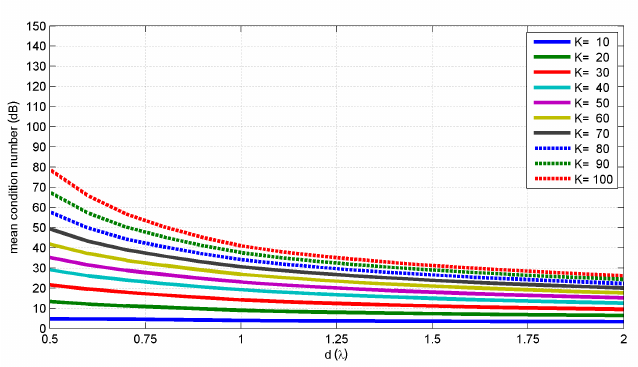
Figure 13. Mean condition number of the channel matrix as a function of the average inter-element distance d and the number of users K for a non-equispaced array with α 1 = − 0.03.